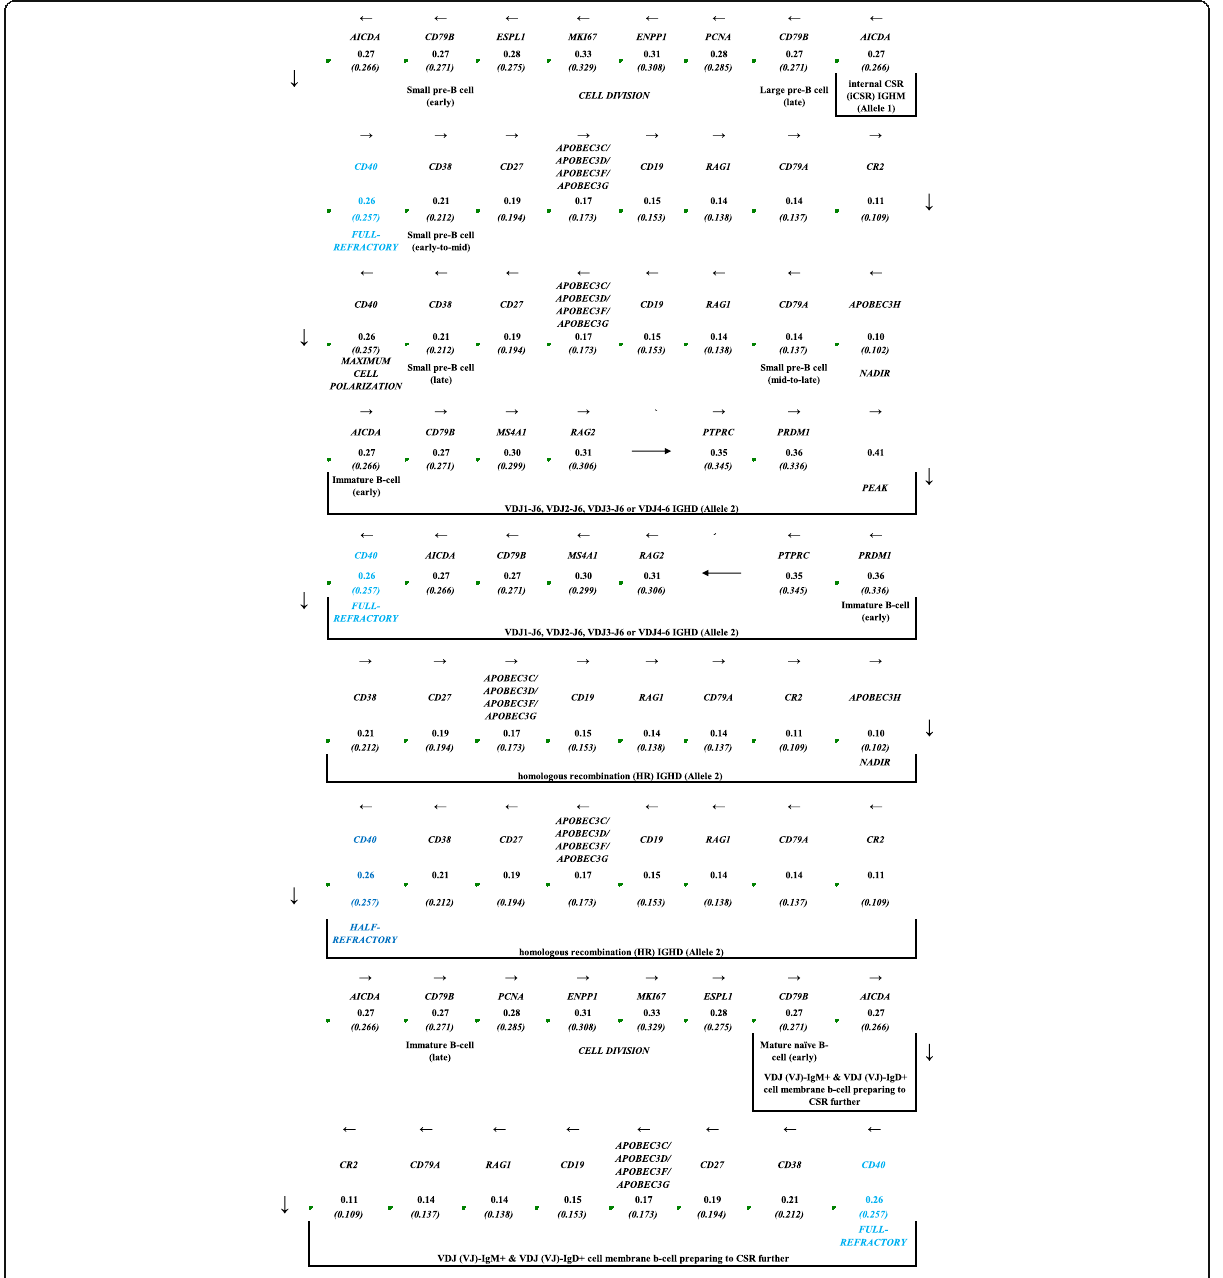
Fig. 1 Pressuromodulation map of B-cell differentiation stages. There are three completed maximal B-cell polarization periods with another to begin (CD40R+), two half-refractory B-cell polarization periods (CD40R±), and four full-refractory B-cell polarization periods (CD40R-) to the 1st generation CM VDJ (VJ)-IgG3+, IgG1+, IgHA1+, IgG4+, IgG2+ or IgE+ (excluding IgA2+) Evolved Mature naïve B-cell preparing to CSR further in the lymph node (2nd phase) after the completing the Immature B-cell phase in the myeloid bone marrow (1st phase). The antigen pressuromodulation effect- mediated extra-lymph nodal long-lived B-plasma cell/plasmablast secretory antibody phase (3rd phase) takes place in the periphery/tissue nidus. Note: The classical pathway B-cell maturation pressuromodulation map is shown, however the map applies to the parallel alternate B-cell maturation path- way wherein the T-cell independent antigen-mediated toll-like receptor (TLR) positive pressuromodulation effect (i.e. endocytic) substitutes for the CD4R+ CD40LG T-cell-mediated CD40R B-cell polarization pressuromodulation effect. † , upper esebssiwaagoT Q units range, 0.41 – 0.36. Black, CD40 at maximum cell polarization potential (CD40R+). Dark blue, CD40 at half-refractory (CD40R±). Light blue, CD40 at full-refractory (CD40R-). Thick black lined large rectangu- lar box, extra-nodal secretory antibody